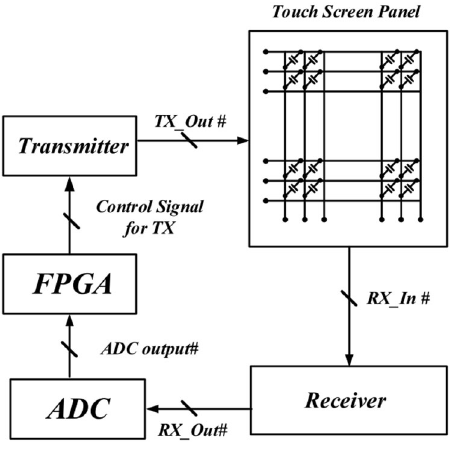
Fig. 15 A proposed high voltage transmitter and the low-noise, low- capacitance sensing circuits for the fi ngerprint touch screen panel. Reproduced with permission from ref. 70. Copyright 2014, IEEE